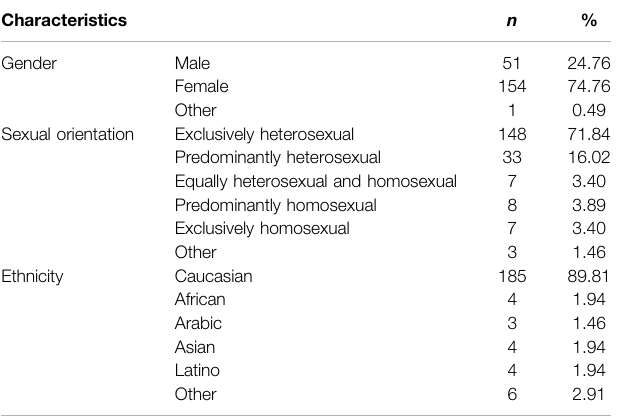
TABLE 1 | Sociodemographic characteristics of participants. Characteristics